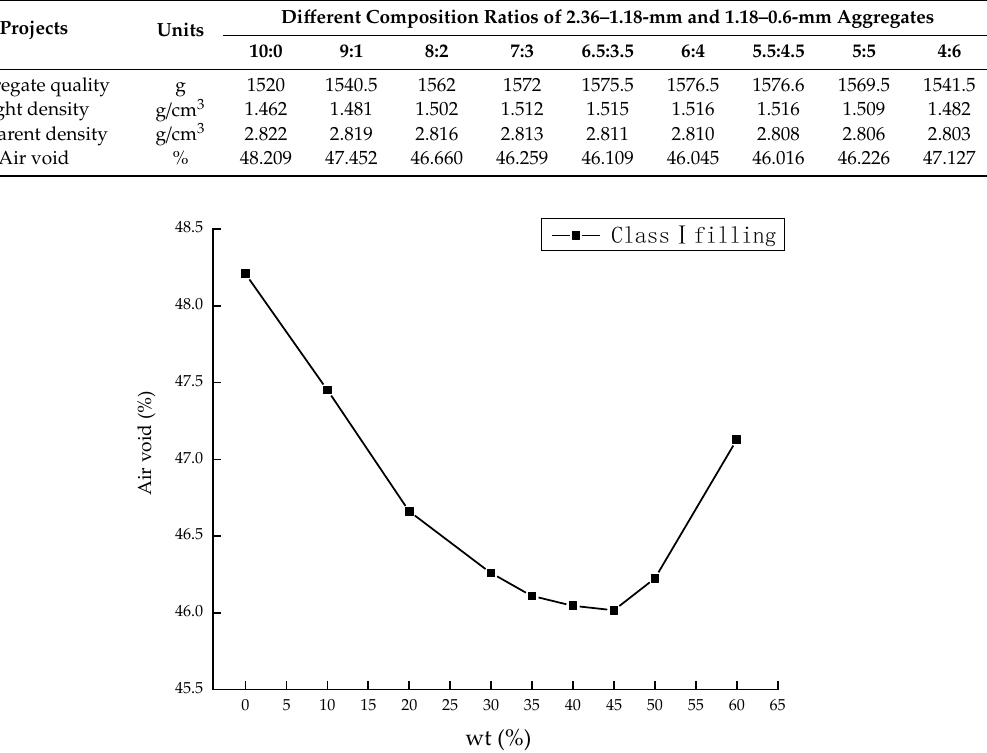
Table 7. Class I filling test results.